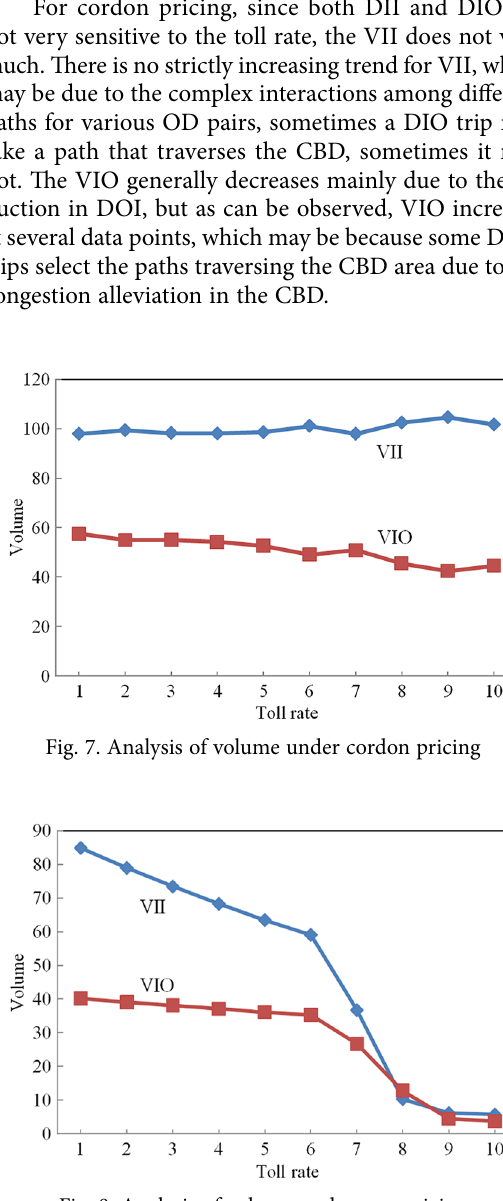
Fig. 8. Analysis of volume under area pricing